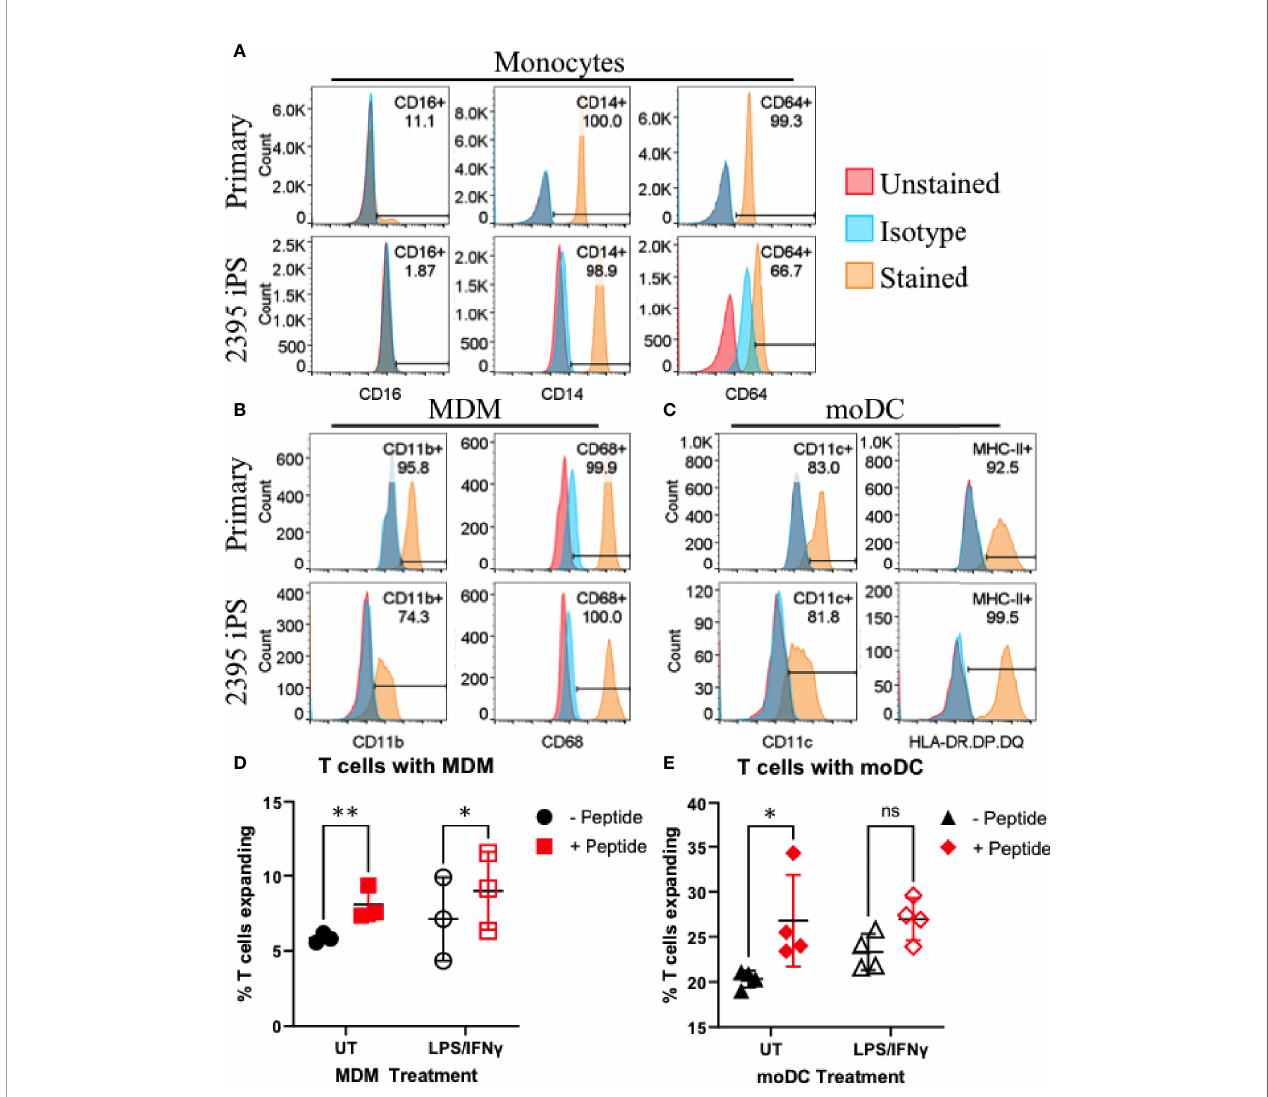
FIGURE 4 | Donor 2395 iPSC differentiate ef fi ciently to monocytes, monocyte-derived macrophages (MDM) and monocyte-derived dendritic cells (moDC) and induce antigen speci fi c CD4 + and CD8 + T cell expansion. (A) Donor 2395 iPSC-derived monocytes are CD16 - , CD14 + , and CD64 + similar to primary classical monocytes isolated from blood. (B) Donor 2395 iPSC-derived MDM express CD11b and CD68 similar to primary MDM. (C) Donor 2395 iPSC-derived moDC express CD11c and MHC-II similar to primary moDC. (D) iPSC-MDM expand Total T cells in an antigen speci fi c manner. When antigen (CEFX peptide pools) is present, there is a signi fi cantly increased expansion of T cells compared to when Total T cells are cultured with APC alone (2-way ANOVA **p = 0.0011 with 3 experimental repeats). (E) iPSC-moDC expand Total T cells in an antigen speci fi c manner. When antigen is present, there is a signi fi cantly increased expansion of T cells compared to when Total T cells are cultured with APC alone (2-way ANOVA *p = 0.0104 with 4 experimental repeats). Signi fi cance shown on the graphs were from post-hoc analysis utilizing the S ̌ ida ́ k method to correct for multiple comparisons. * indicates that p < 0.05, ** indicates that p < 0.01, and ns indicates not signi fi